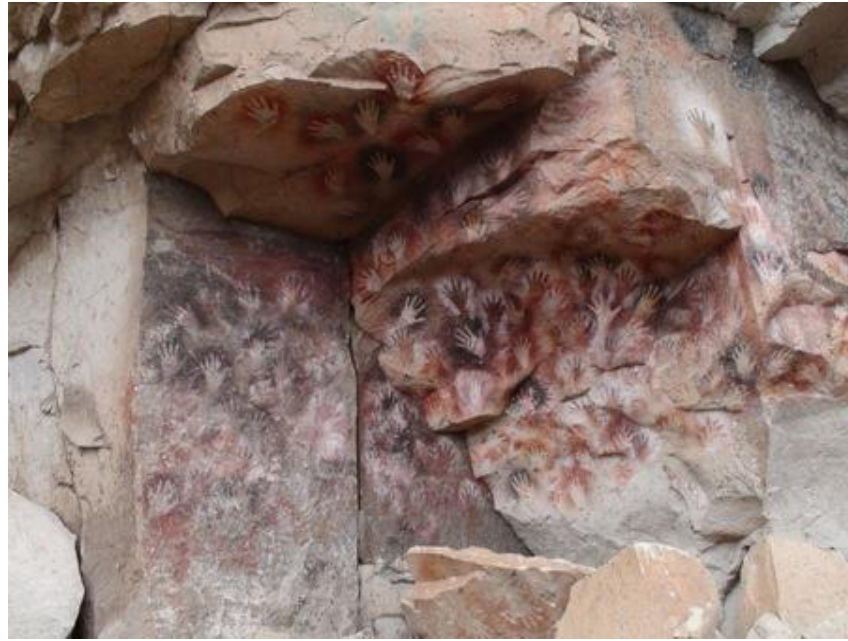
Figure 4. Cueva de las Manos, Santa Cruz, Argentina. (For green stencil see top centre.)